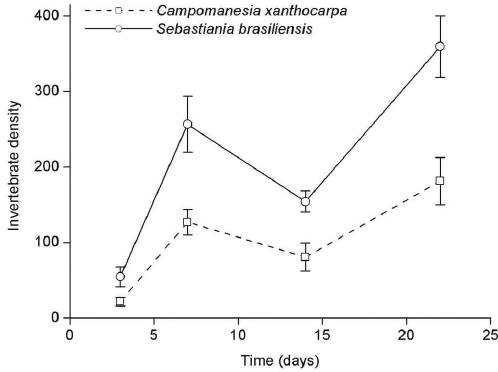
Figure 3. Percentage of functional feeding groups (ex- cluding chironomids for functional feeding classification) of invertebrate community on leaves of tree species dur- ing breakdown of C. xanthocarpa a) and S. brasiliensis b) leaves in a subtropical